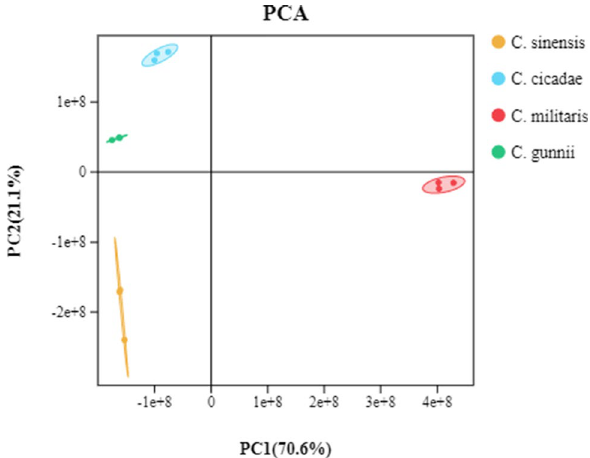
Figure 1. PCA results of C. sinensis , C. cicadae , C. militaris and C. gunnii samples and quality